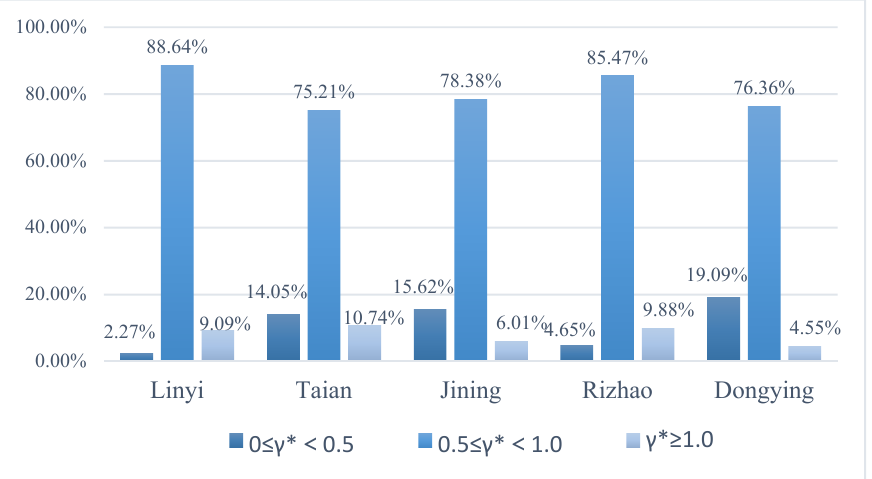
Figure 3. Distribution of the GUECL of farming households in five surveyed cities.